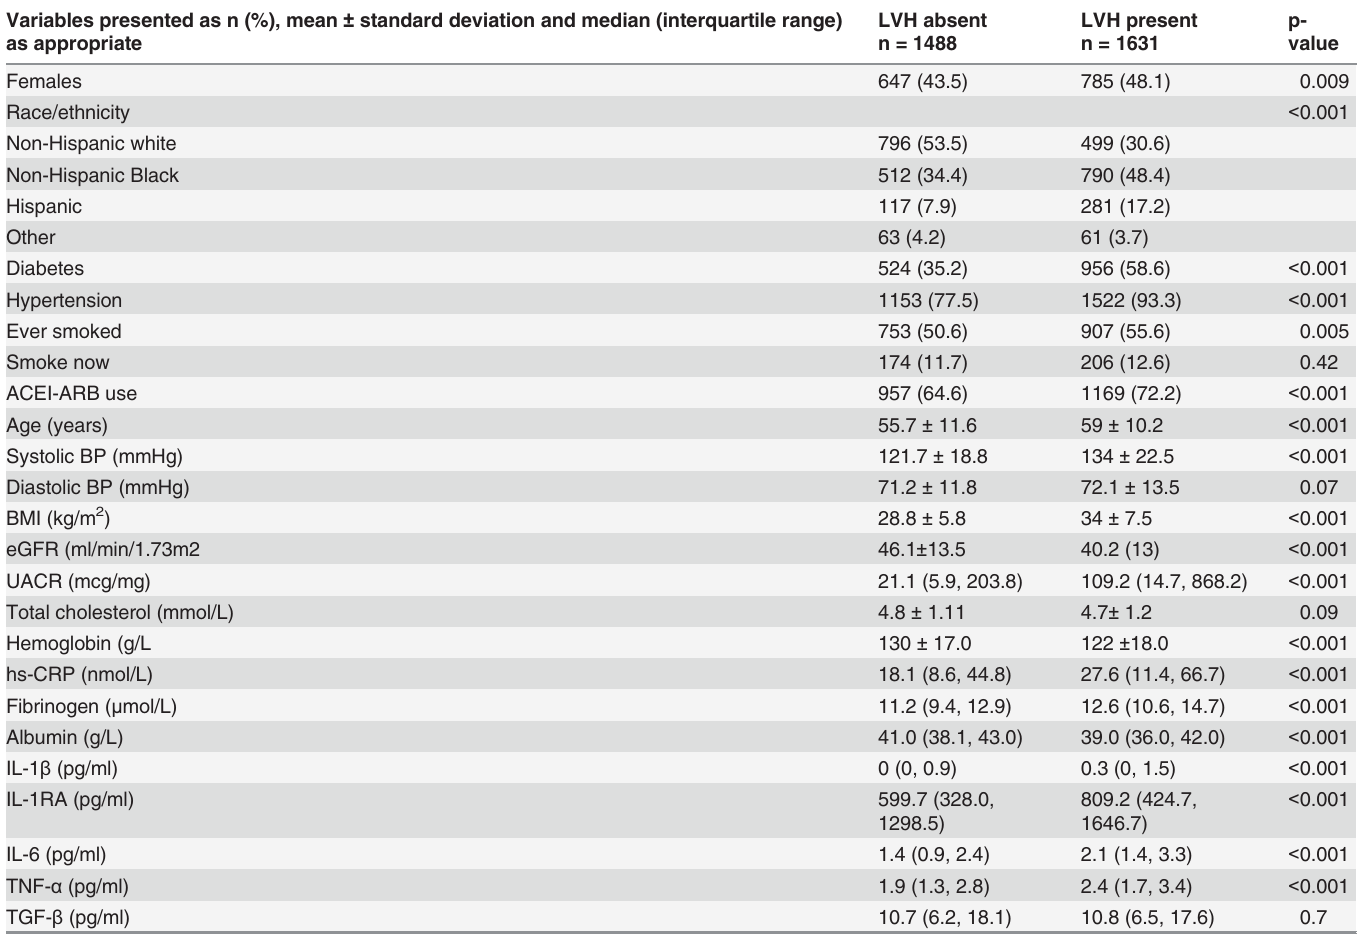
Table 1. Baseline demographic and clinical characteristics of the study cohort categorized by the presence of LVH. Variables presented as n (%), mean ± standard deviation and median (interquartile range) as